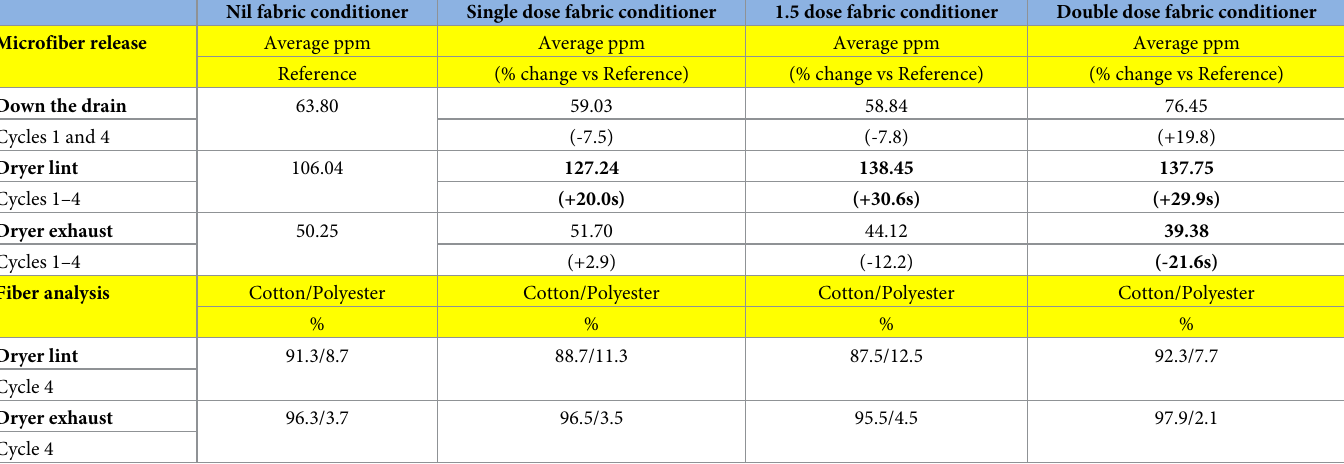
Table 1. Summary of microfiber release and fiber analysis data–North America liquid fabric conditioner